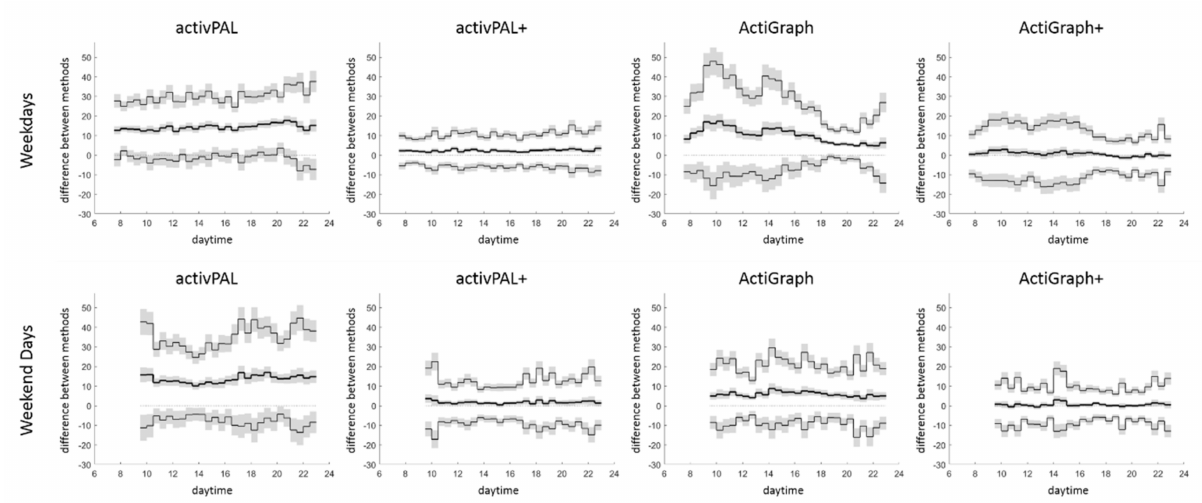
Figure 2. Bland–Altman plots for average sedentary time per day, expressed in minutes per day. The bias (bold line) and 95% limits of agreement (thin lines) are indicated, both with 95% confidence intervals (in grey). The corresponding figure in per cent of wear-time is given in the Supplementary Materials (Figure S1).